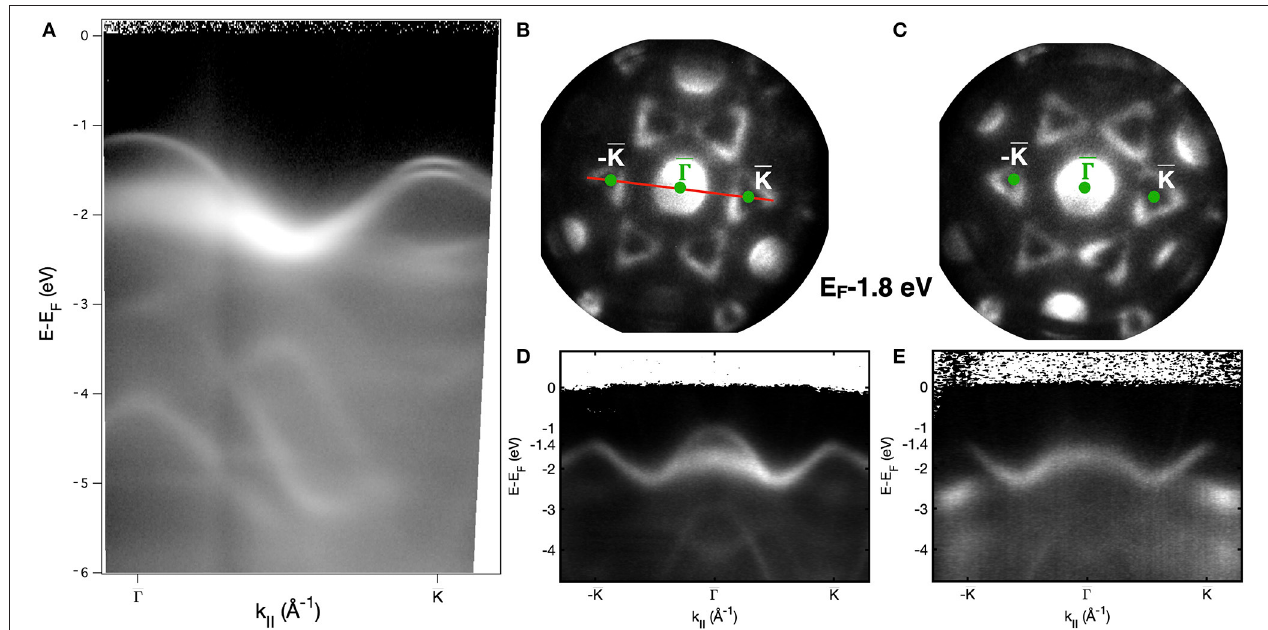
FIGURE 3 | (A) A more detailed measurement of bilayer MoS 2 along the ¯ Ŵ − ¯ K direction shows the band splitting of 0.14eV at the ¯ K point; the gap between the band maxima at ¯ Ŵ and ¯ K is 0.35eV, which is not observed for single-layer MoS 2 . (B,C) Two-dimensional photoelectron angular distribution patterns of the two MoS 2 mirror domains at 1.8eV below the Fermi level from selected-area ARPES measurements. Both the minority domain (see B ) and the majority domain (see C ) exhibit a 3-fold symmetry of the first order ¯ Ŵ points in a mirror configuration. The ARPES data along the −¯ K − ¯ Ŵ − ¯ K direction (exemplarily indicated by the red line in B ) exhibits the typical bandstructures for (D) bilayer MoS 2 (recorded at RT), with an additional band at the ¯ Ŵ point for the bilayer, and (E) for single-layer MoS 2 (recorded at 720 ◦ C).